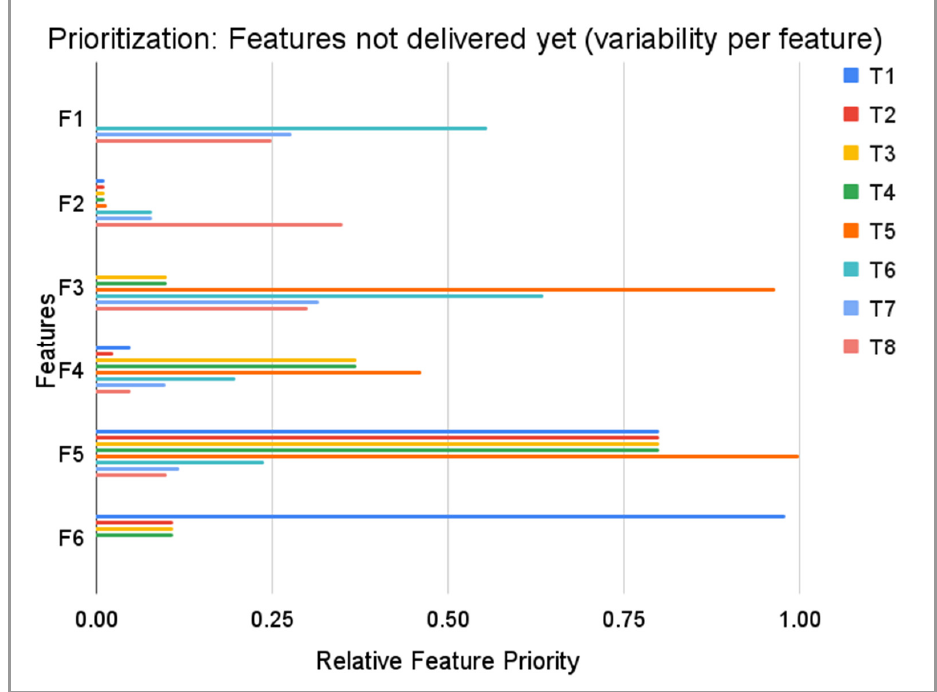
Figure 4. Changes in prioritisation per feature: features not yet delivered.